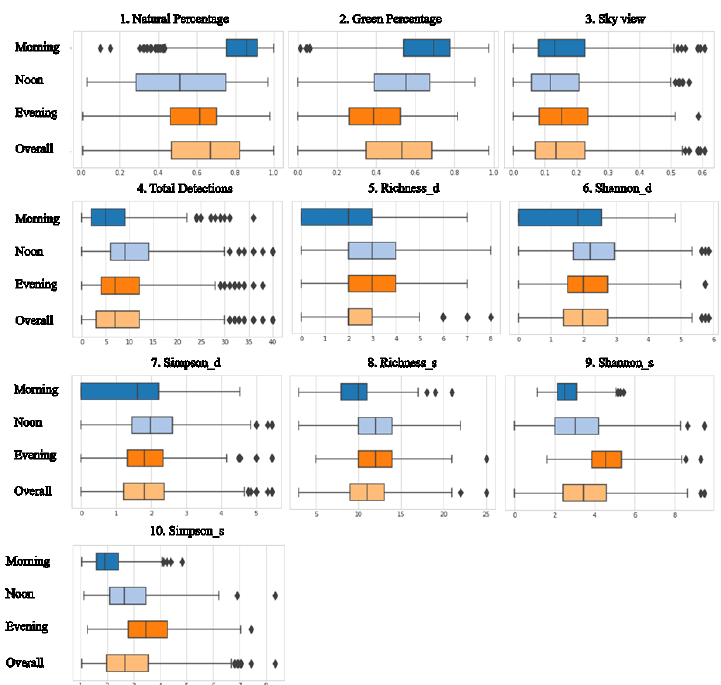
Figure A1. Boxplots showing variation in various environmental variables during the morning, noon, and evening. Note: 1: Natural percentage is calculated with the segmentation task by the addition of detected natural elements; 2: Green percentage is the presence of trees and grass in the scene; 3: Sky view is the percentage of visible sky in the segmentation task; 4: The total detection of elements in the scene with the help of the object detection task; 5: The Richness index of the detection task; 6: Shannon index of the detection task; 7: Simpson index of the detection task; 8: Richness index of the segmentation task; 9: Shannon index of the segmentation task; 10: Simpson index of the segmentation task.